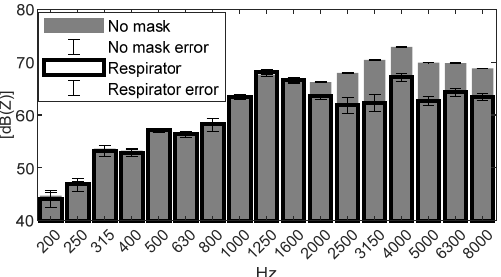
Figure 7. Acoustic pressure of a 1/3 octave spectrum for the condition without the mask (grey bar) and for the condition with one of the masks (black bar). The decibel reference is 20 µPa.